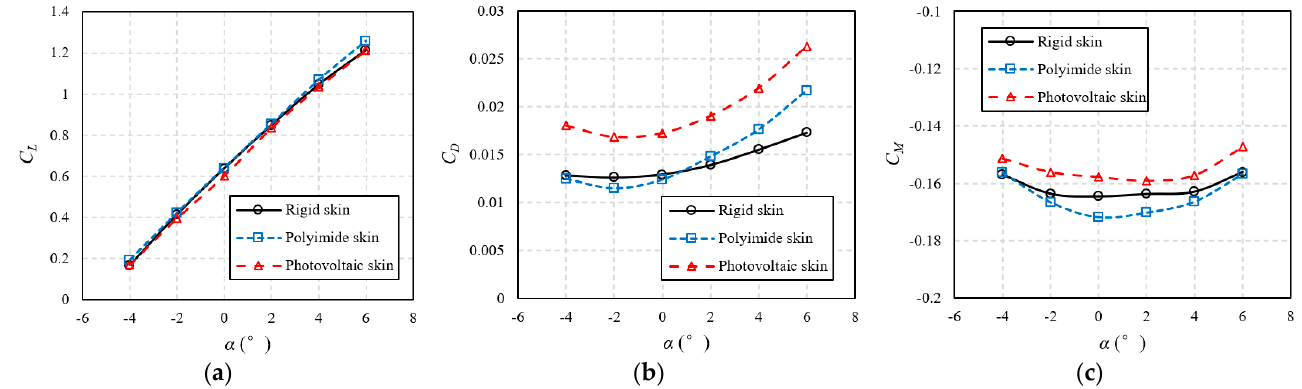
Figure 13. Aerodynamic characteristics of wings with three different skins v = 9.0 m/s: ( a ) C L - α ; ( b ) C D - α ; ( c ) C M - α .